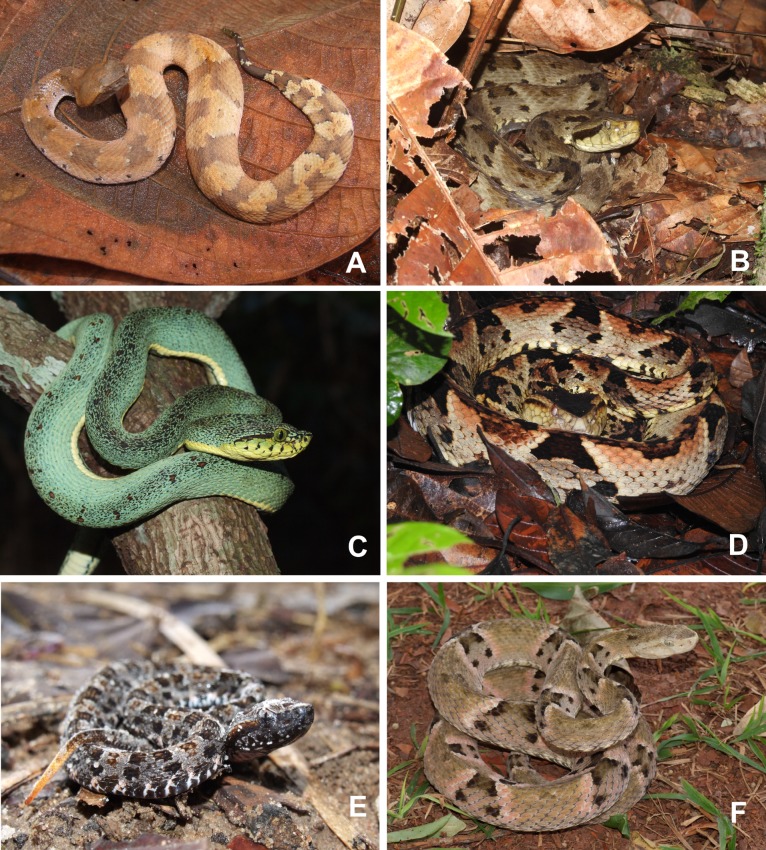
Some species responsible for Bothrops envenomings in the Brazilian Amazon and surrounding cerrado areas.a) Bothrocophias hyoprora; b) Bothrops atrox; c) Bothrops bilineatus bilineatus; d) Bothrops brazili; e) Bothrops moojeni; f) Bothrops mattogrossensis.